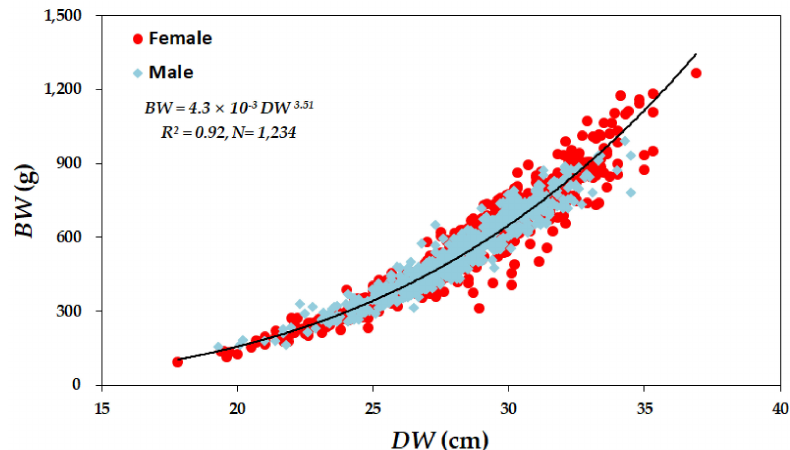
Figure 5. Relationship between BW and DW of ocellate spot skate Okamejei kenojei in the West Sea of